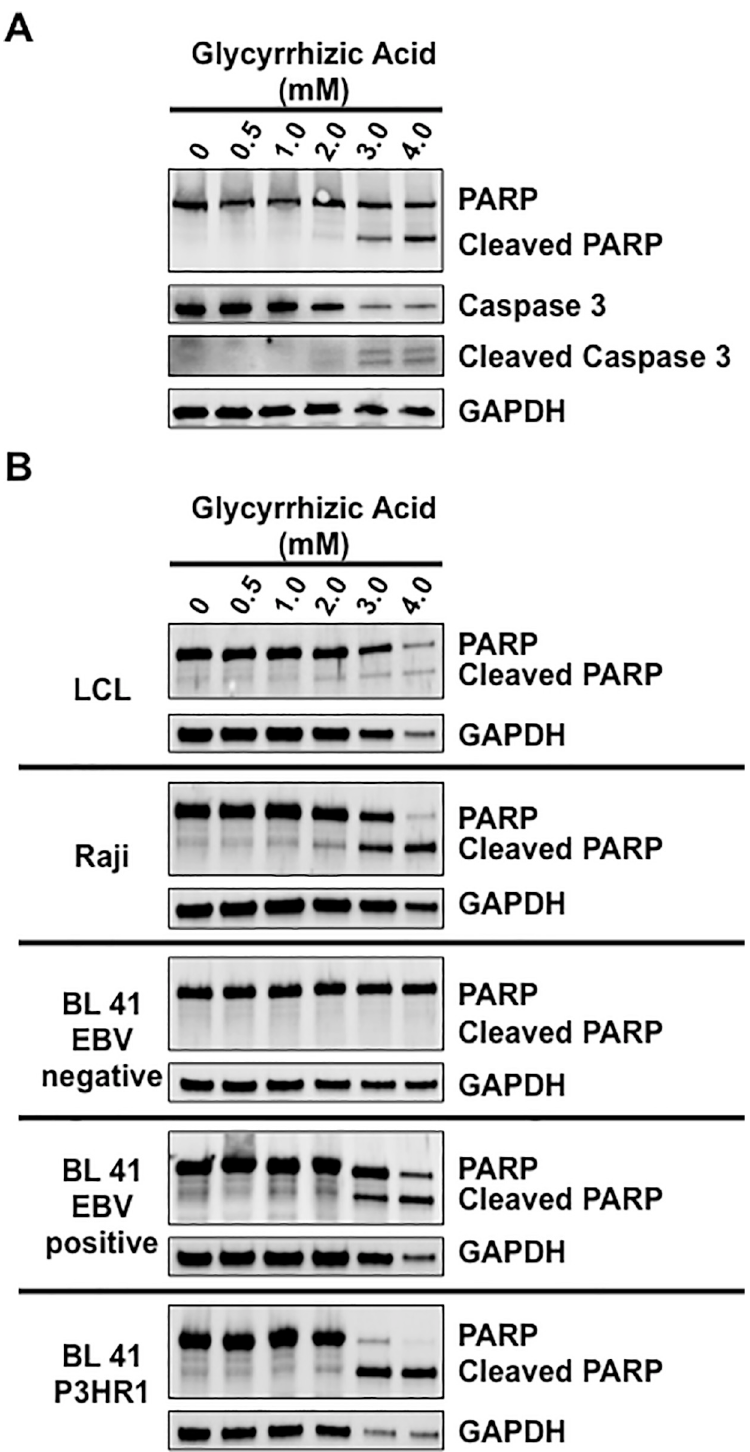
Fig 3. Higher doses of glycyrrhizic acid induced LCL apoptosis. A) LMP1-expressing HEK 293 cells and B) LCLs, Raji cells, BL 41 EBV negative cells, BL 41 EBV positive cells, and BL 41 P3HR1 cells were treated with graduated doses of glycyrrhizic acid. 48 hours post-treatment, cells were harvested, lysed, denatured, and Western blot analyses performed to detect total and cleaved PARP, caspase-3, or GAPDH.